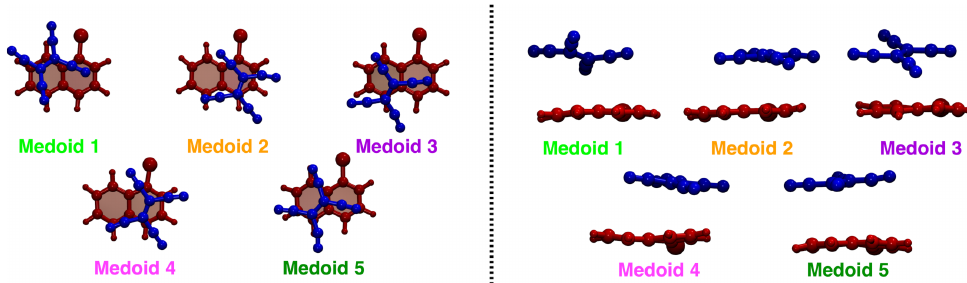
Figure 3. Structures of the five cluster medoids in top ( left panel) and side ( right panel) views. The TCNE and 1ClN are represented as ball and stick in blue and red, respectively. The color code is uniform with that of Figure 4.